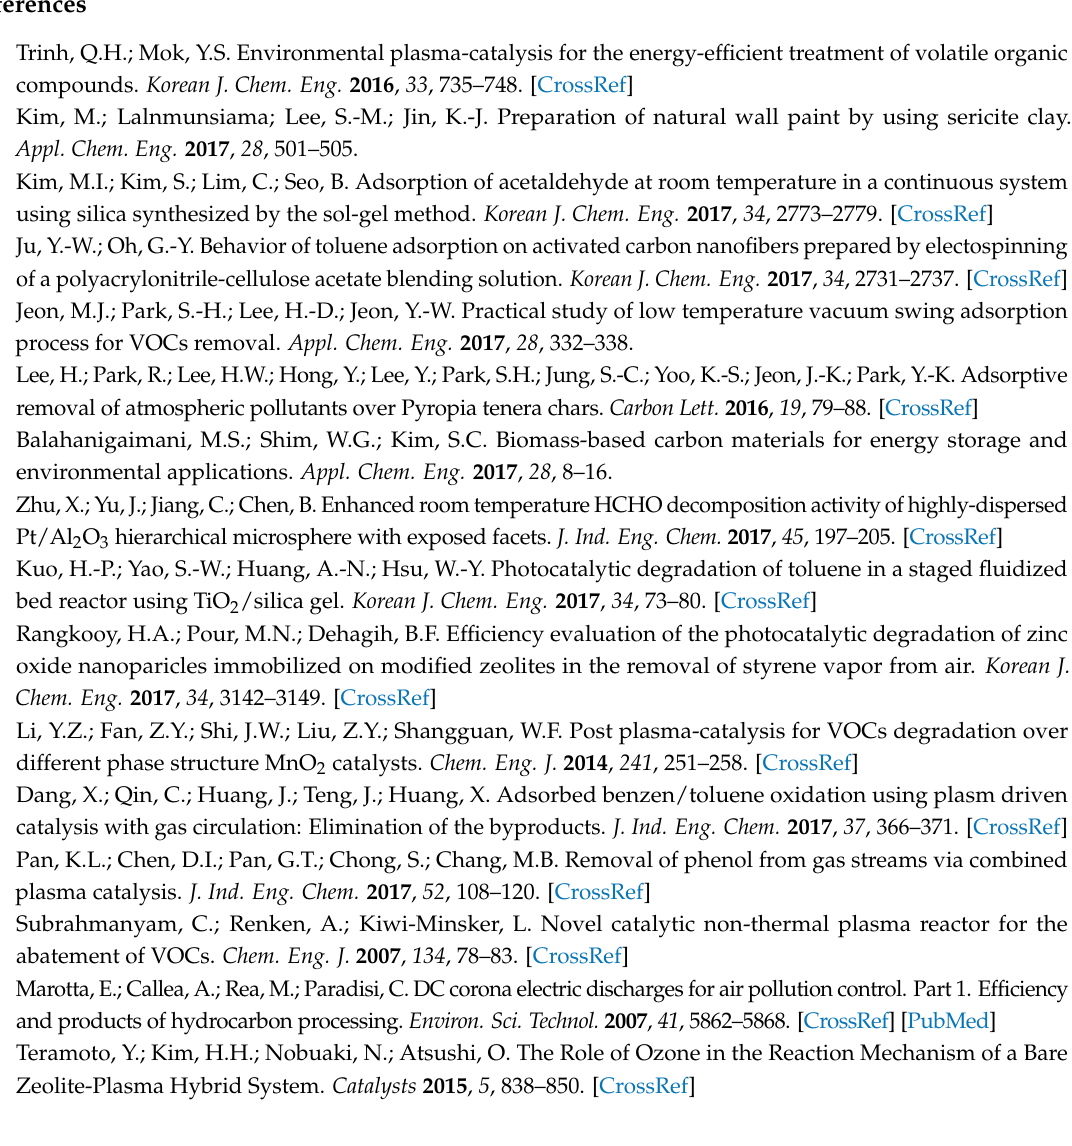
Figure S1: XRD of the treated Mn/NZ and untreated Mn/NZ of sonication, Figure S2: The effect of humidity on the catalytic activity of the 10 wt.% Mn/NZ for the acetaldehyde oxidation and the ozone